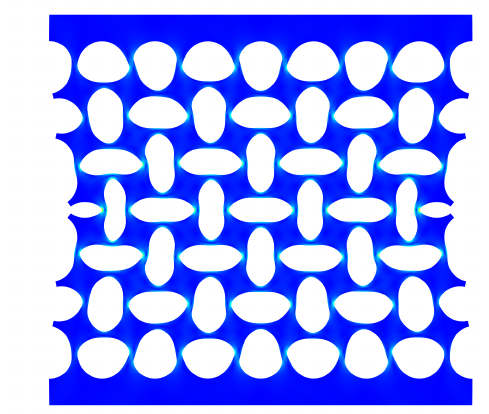
Figure 14. Computed deformed state of a finite 8 × 7 structure. The middle cells are much more deformed than the top and bottom